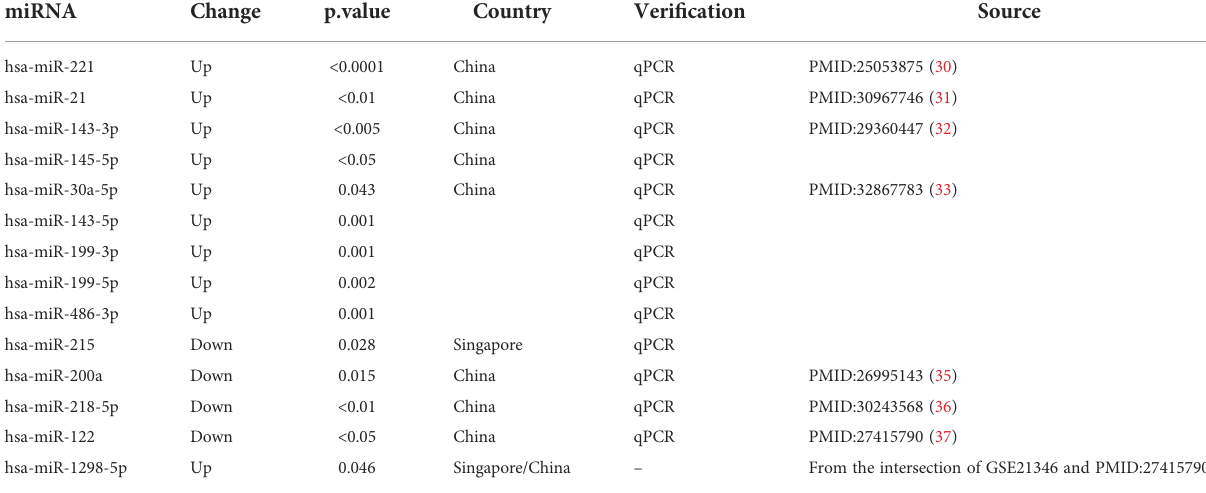
TABLE 1 The information on miRNA for further analysis.